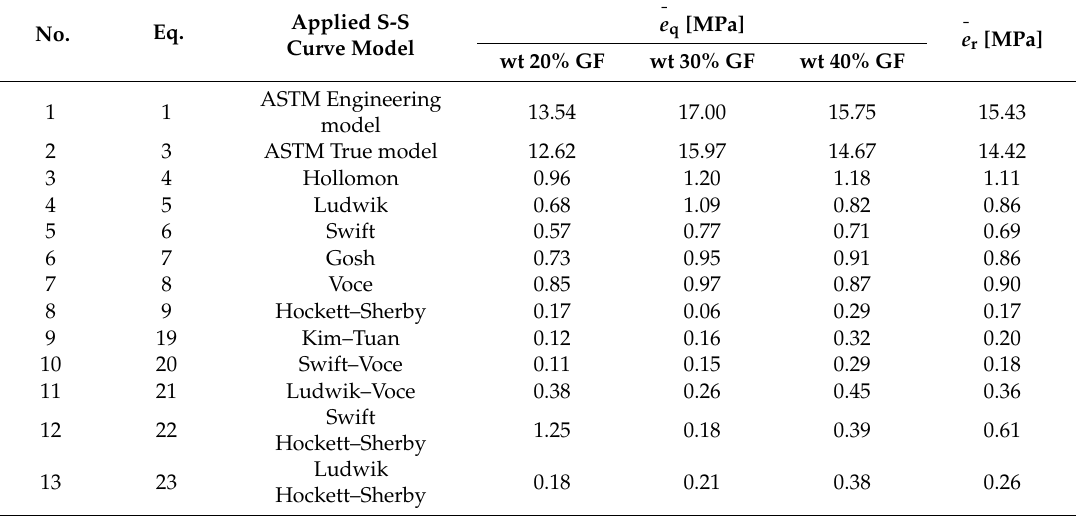
Figure 10. Error values of the optimized inverse method models: ( a ) optimized inverse models of GFRP wt 20% GF; ( b ) optimized inverse models of GFRP wt 30% GF; ( c ) optimized inverse models of GFRP wt 40% GF. Table 3. Optimized values of the advanced inverse method.